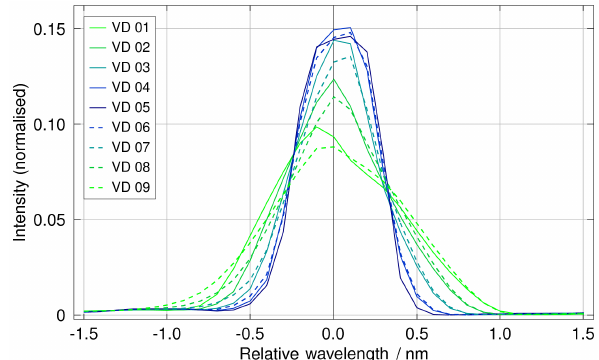
Figure 5. Experimental slit functions of the AirMAP instrument for campaign conditions in June 2011. The spectral resolution lies between 0.5 and 1.0nm for the central and the outer viewing direc- tions,